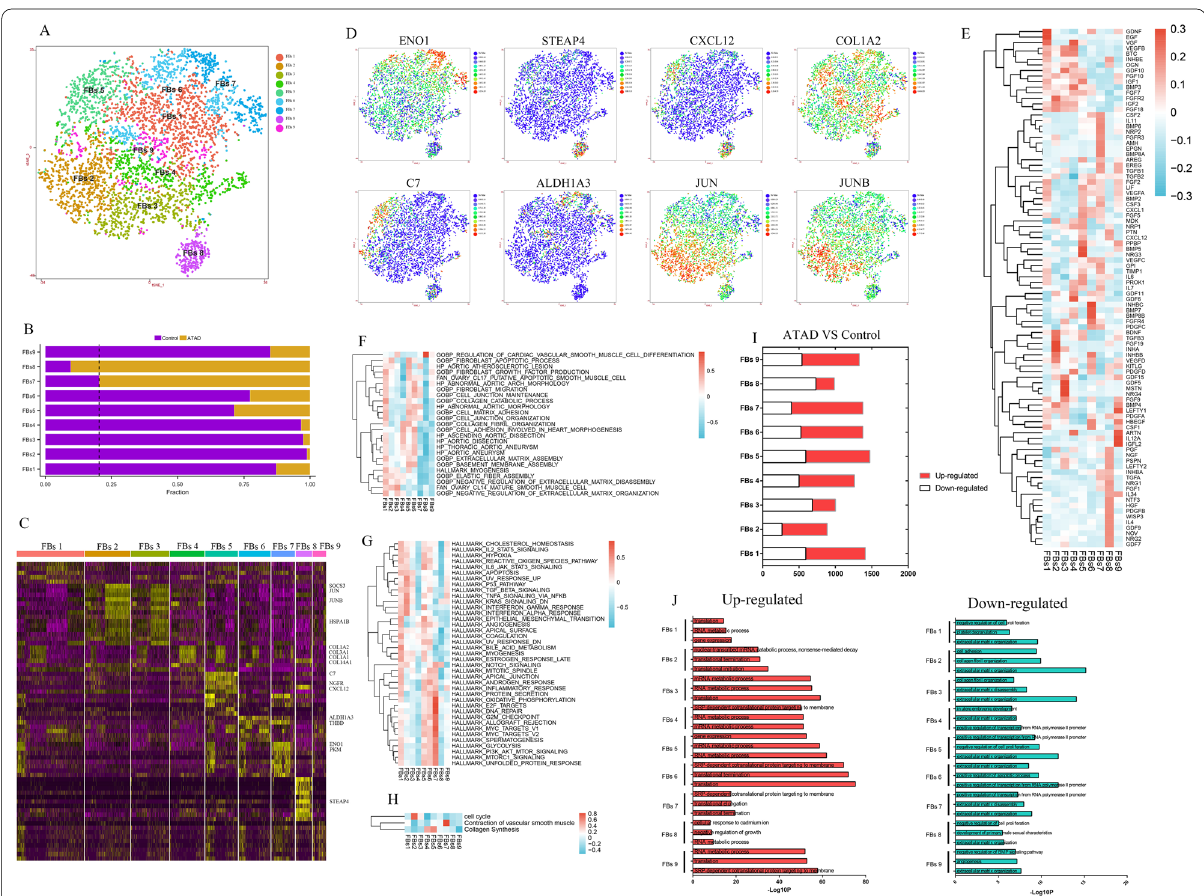
Fig. 2 Nine subpopulations of FBs were identified with differential markers and functions. A t‑SNE plot showed 9 subpopulations of FBs after re‑clustering. B The proportion of each subpopulation of FBs between control and ATAD group. The dashed line was used to distinguish the dominant subpopulations in ATAD and control group. C Heatmap of marker genes for each subpopulation of FBs. D t‑SNE plots showed the expressions of representative marker genes for each subpopulation of FBs. E The expressions of growth factors in subpopulations of FBs. F Qusage analysis of selected gene‑sets enrichment relating to ATAD and FBs functions for each subpopulation of FBs. G Qusage analysis of hallmark gene‑sets enrichment for each subpopulation of FBs. H the results of Qusage analysis to identify functions of contraction, collagen synthesis and proliferation for each subpopulation of FBs. I DEGs in subpopulations of FBs (ATAD/Control). J GO analysis for up‑regulated and down‑regulated genes in subpopulations of FBs